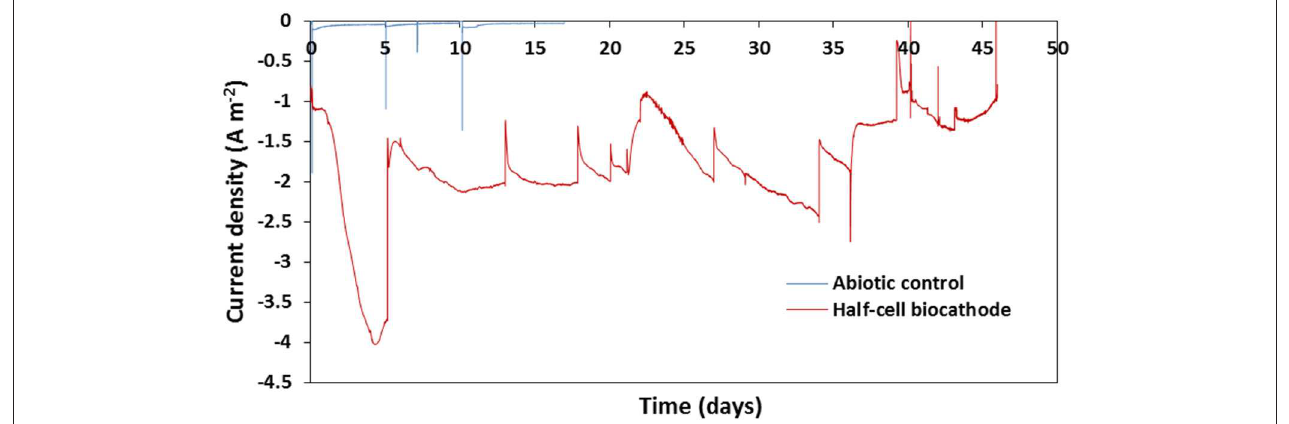
FIGURE 3 | Chronoamperometry of half-cell poised at 0.2V and inoculated by enriched IOB during the 47 day experiment and control half-cell during the 17 days abiotic experiment.